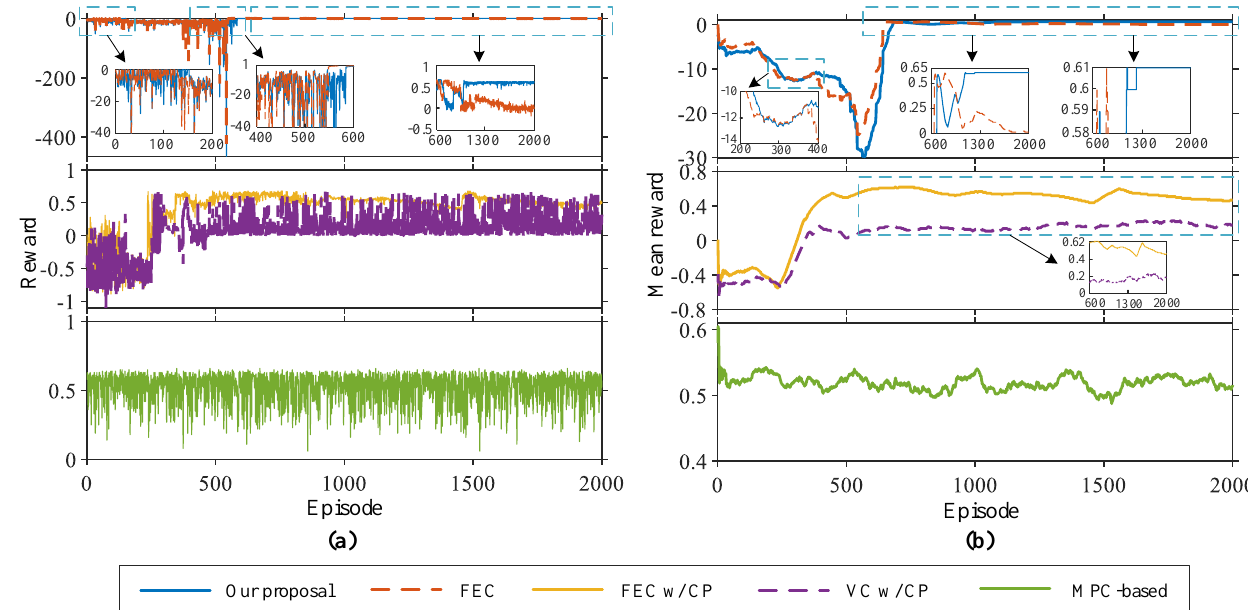
Figure 8. Changing of episode reward achieved during training, where ( a ) is episode reward for the five strategies, respectively, ( b ) is episode mean reward for the five strategies, respectively, and mean reward is the average of mean episode rewards across a rolling window with size 100. Table 3. CF situations with different strategies in collision episodes achieved during training.